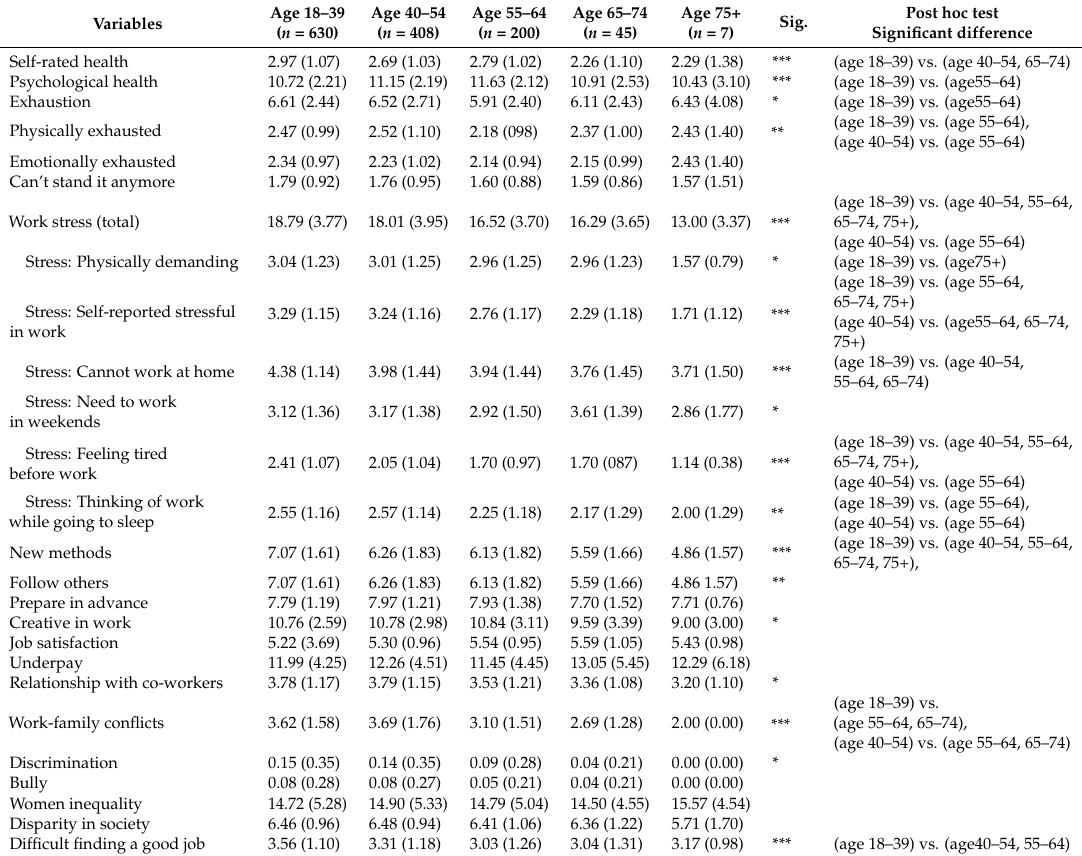
Table 2. Age group differences in well-being and work factors by one-way